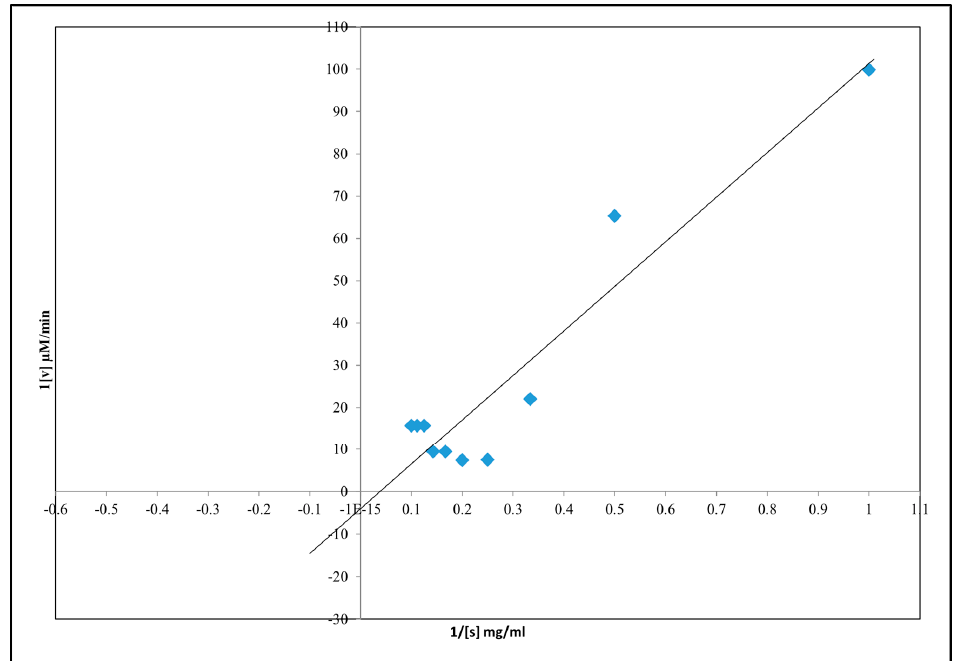
Figure 8. Inhibition kinetics of α -glucosidase activity.